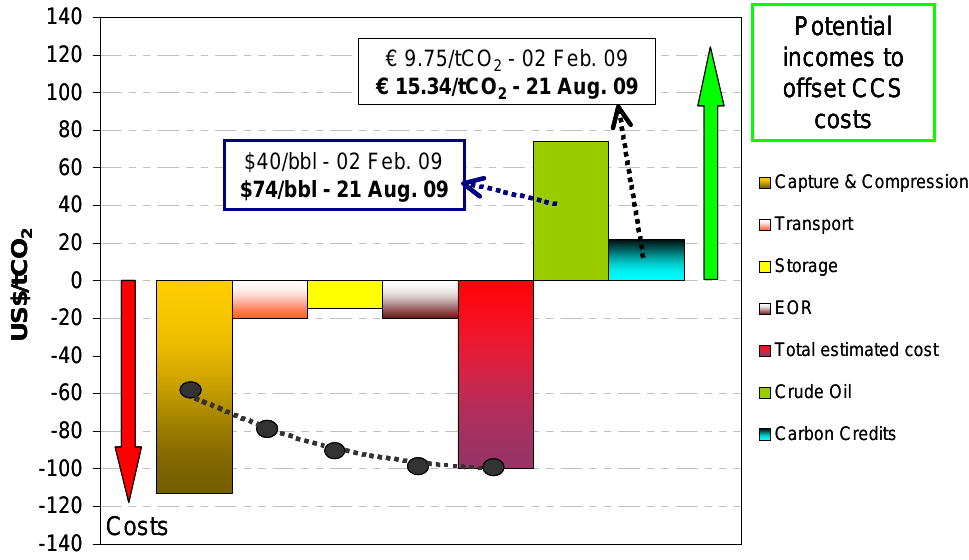
Figure 6. Example of total costs and potential incomes of carbon capture storage projects with EOR (CO -EOR 2